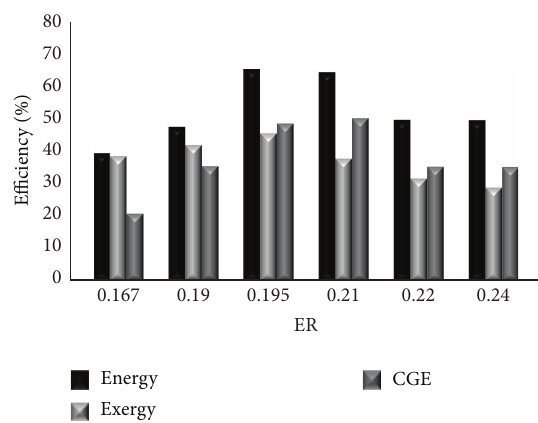
Figure 2: Influence of ER of on cold gas, energy and exergy